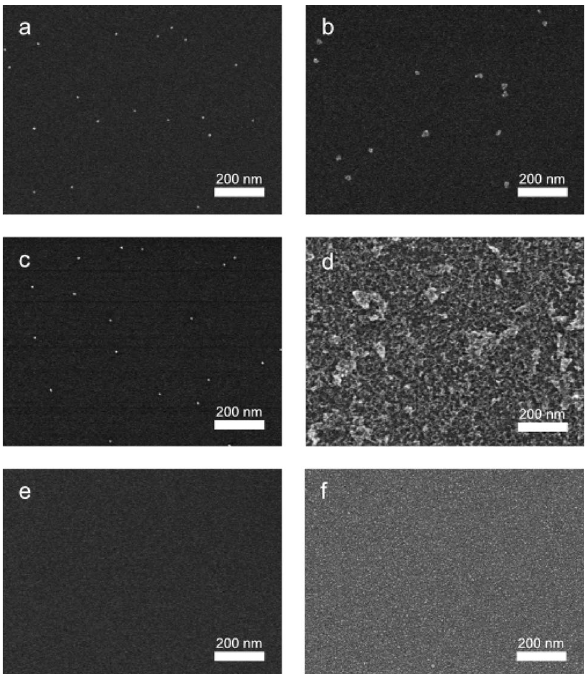
Figure 4. PdNP/Si chip ( a ) before and ( b ) after treatment in 95 °C dioxane. Clustering of nanoparticles into small, compact agglomerates. AuNP/GaP chip ( c ) before and ( d ) after treatment at 95 °C in H 2 O.